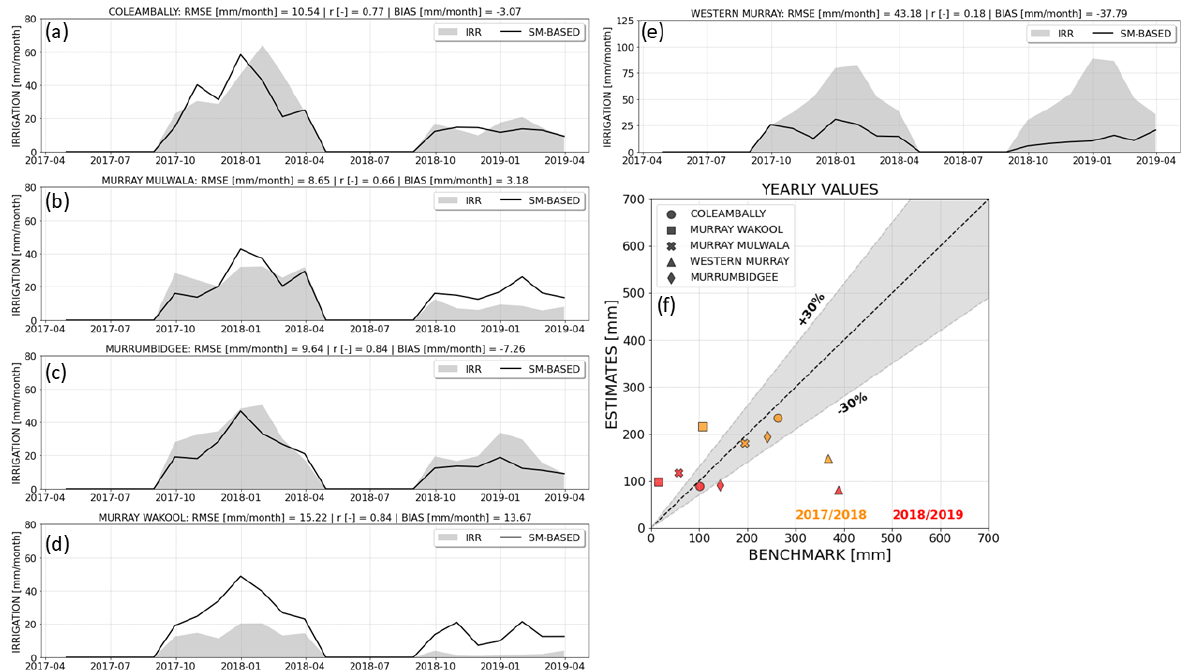
Figure 9. (a–e) The 14d aggregated time series of irrigation estimates (the black lines) over the five considered pilot districts within the Murray–Darling basin against the benchmark rates (the light grey shaded areas). (f) Yearly comparison with data referring to different districts and years indicated through different markers and colors, respectively. The interval indicating a relative error of ± 30% is shown as